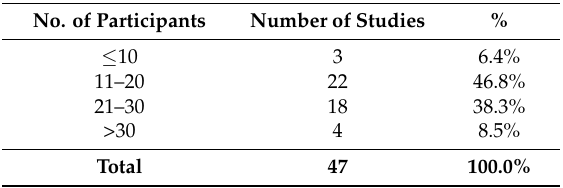
Table 6. Number of participants in gesture elicitation studies.